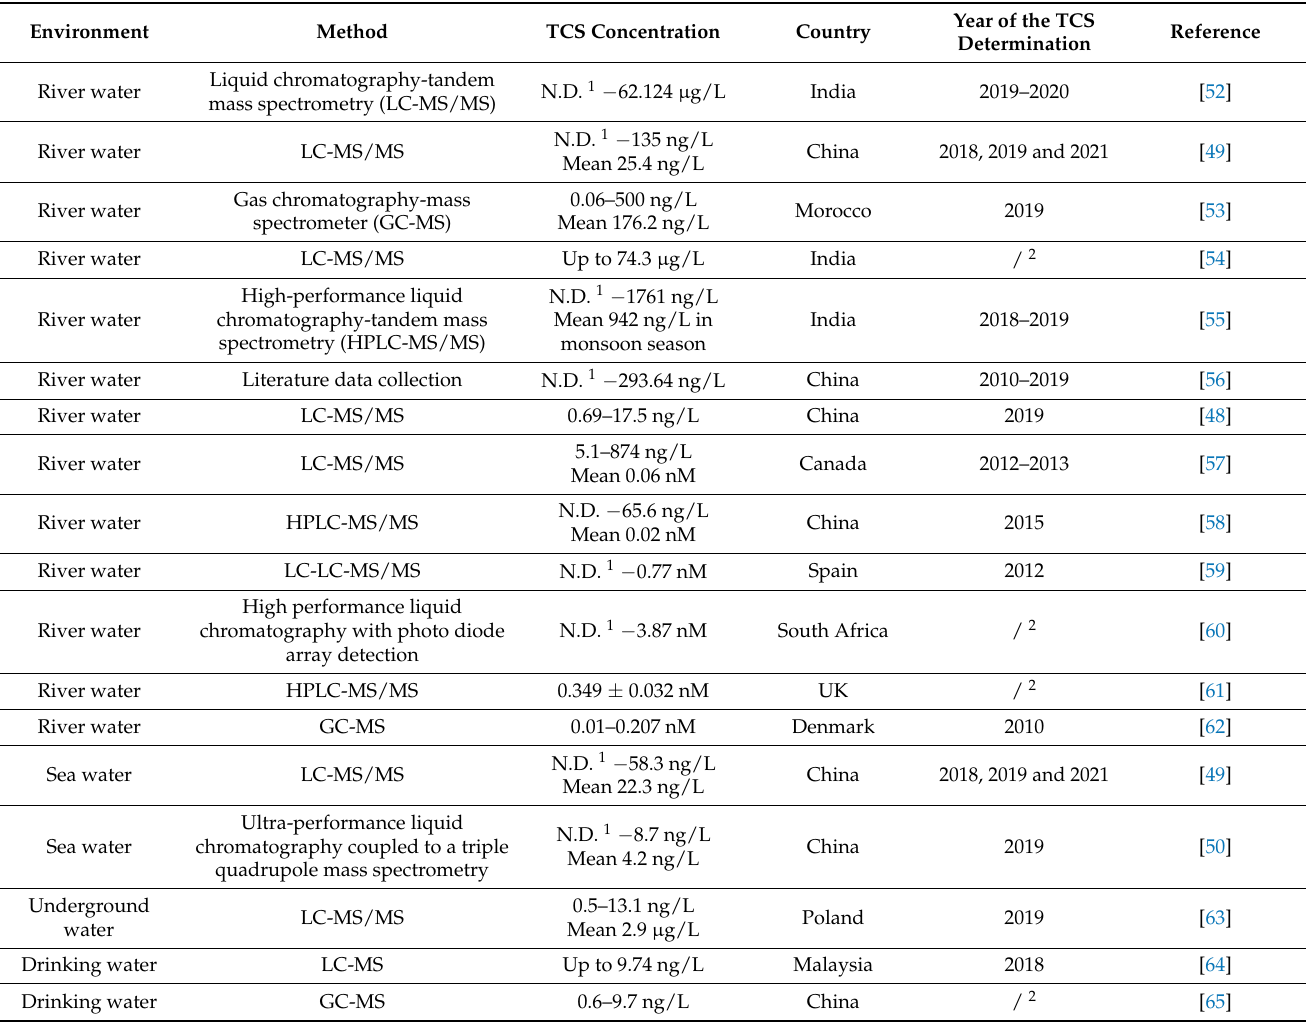
Table 2. The concentrations of TCS in different water